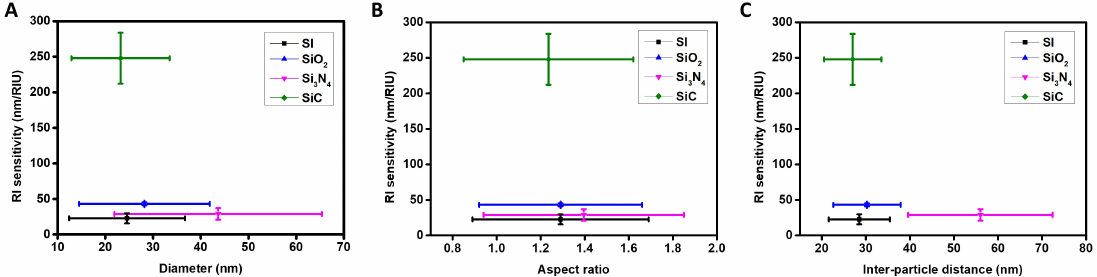
Figure 6. LSPR refractive index sensitivity of AuNI (1.00–1.47) plotted against the morphological variations of AuNI. ( A ) The Refractive Index (RI) sensitivity with respect to the mean diameter of AuNI. ( B ) Effect of the shape of the AuNI on LSPR sensitivity. ( C ) Effect of the inter-particle distance of NI.